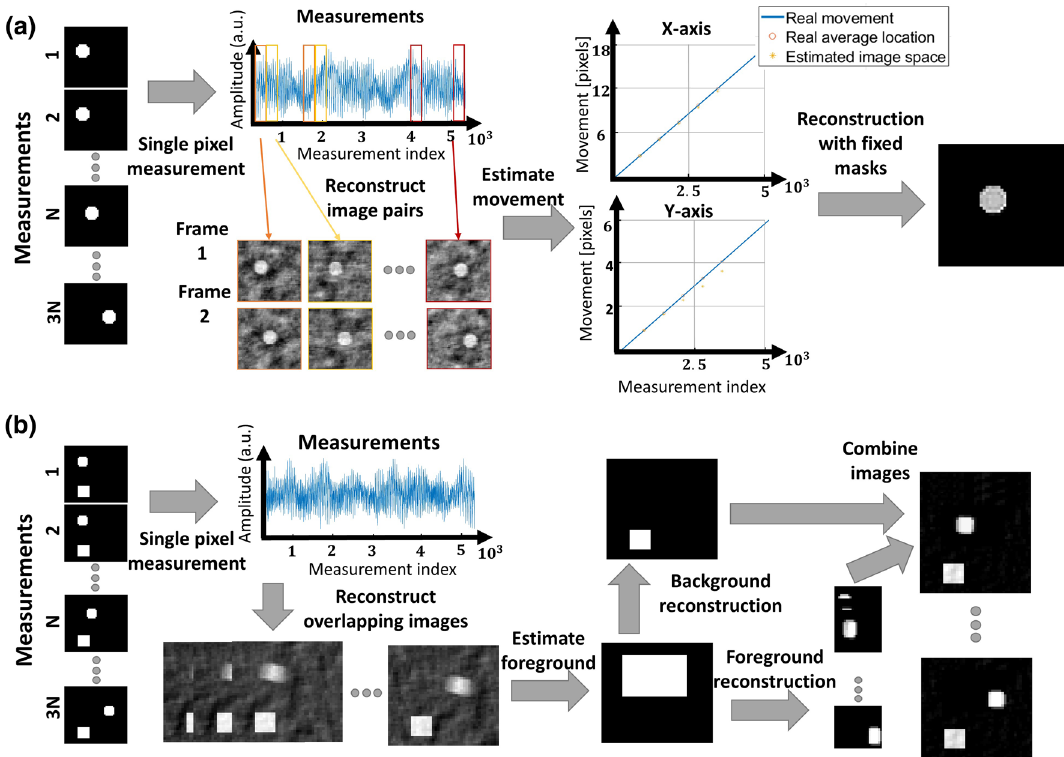
Figure 2. Schematic of the two proposed algorithms ( a ) Flow of the algorithm in case of global motion. ( b ) Flow of algorithm in case of local